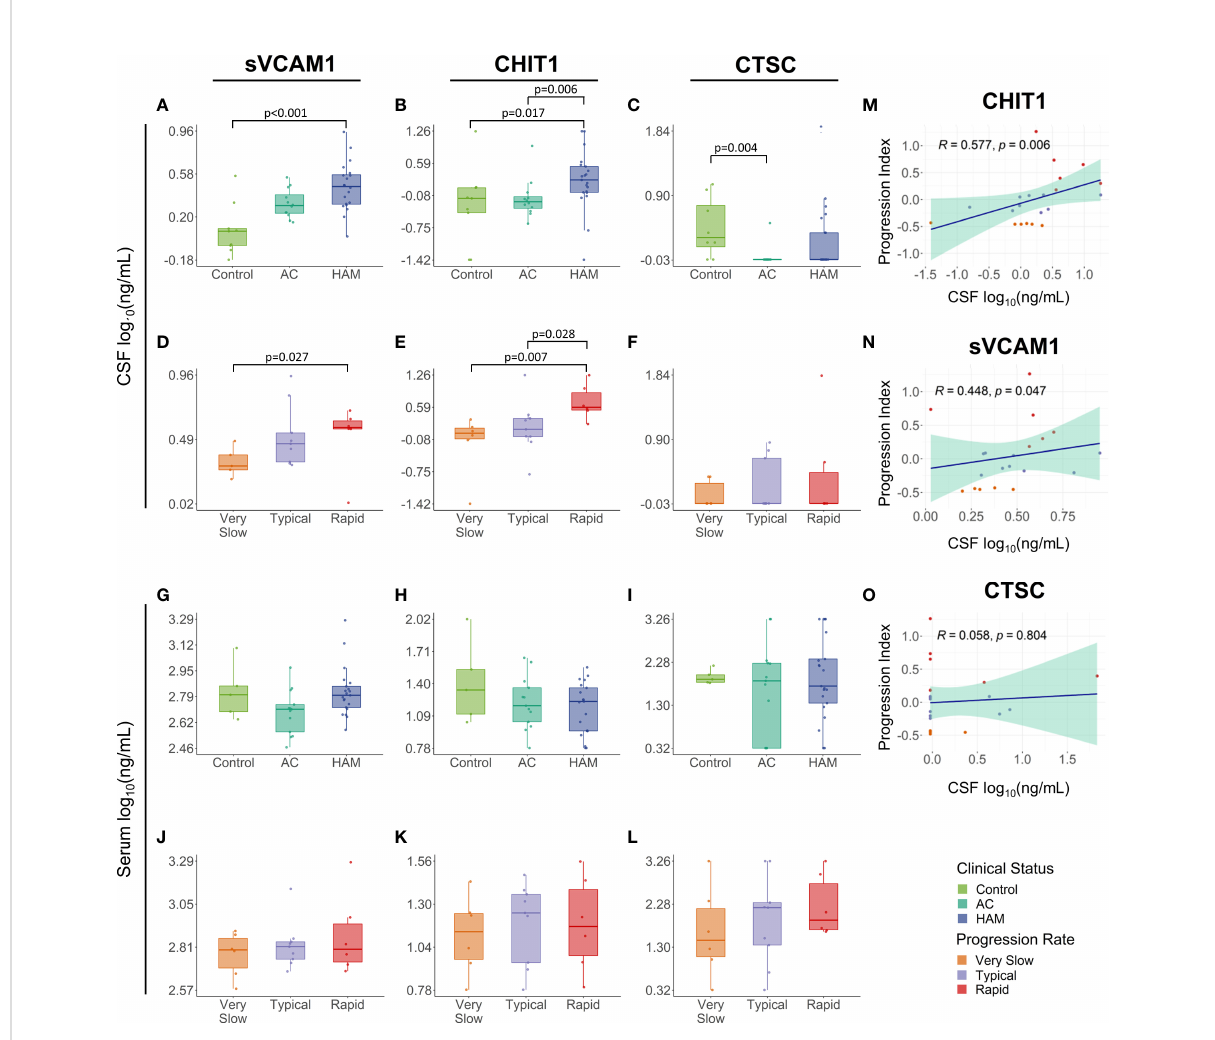
FIGURE 2 Validation of proteome fi ndings in the cerebrospinal fl uid (CSF). sVCAM-1, chitotriosidase 1 (CHIT1), and cathepsin C (CTSC) concentration were determined by ELISA in paired (A – F) CSF and (G – L) serum samples from HTLV-1-infected individuals identi fi ed according to their clinical status as HTLV-1 asymptomatic carriers (AC) (n=13) and HAM/TSP patients (n=21). The CSF (n=9) and serum samples (n=5) from individuals with non- in fl ammatory and non-infectious neurological diseases were used as a control. HAM/TSP patients were also subdivided according to the speed of disease progression as very slow (n=6), typical (n=9) and rapid (n=6). The statistical analysis was performed with Kruskal-Wallis test, followed by Dunn ’ s posthoc test. Unadjusted p -values were used and differences with p < 0.05 were considered signi fi cant. (M – O) The association of the HAM/ TSP progression index, de fi ned by the speed of neurological deterioration in the IPEC-2 disability scale and the time of disease, and the CSF levels of CHIT1, sVCAM-1, and CTSC was evaluated by Spearman ’ s rank of correlation analysis, and p -values < 0.05 were considered signi fi